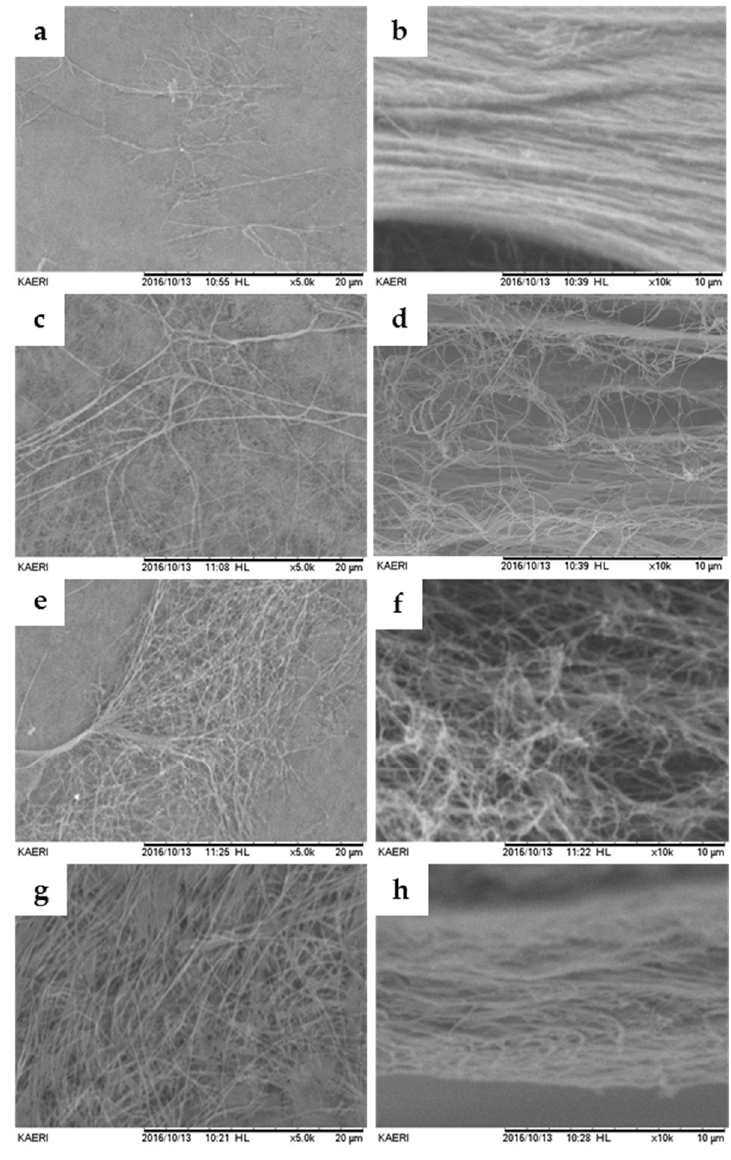
Figure 1. Scanning electron microscope (SEM) images of the surface and cross-section of bacterial cellulose (BC) and collagen membranes. ( a , b ) Collagen membrane; ( c , d ) 0.10 mm BC membrane; ( e , f ) 0.15 mm BC membrane and ( g , h ) 0.20 mm BC membrane (original magnification: surface, ×5k (a,c,e,g); cross-section, ×10k (b,d,f,h)).